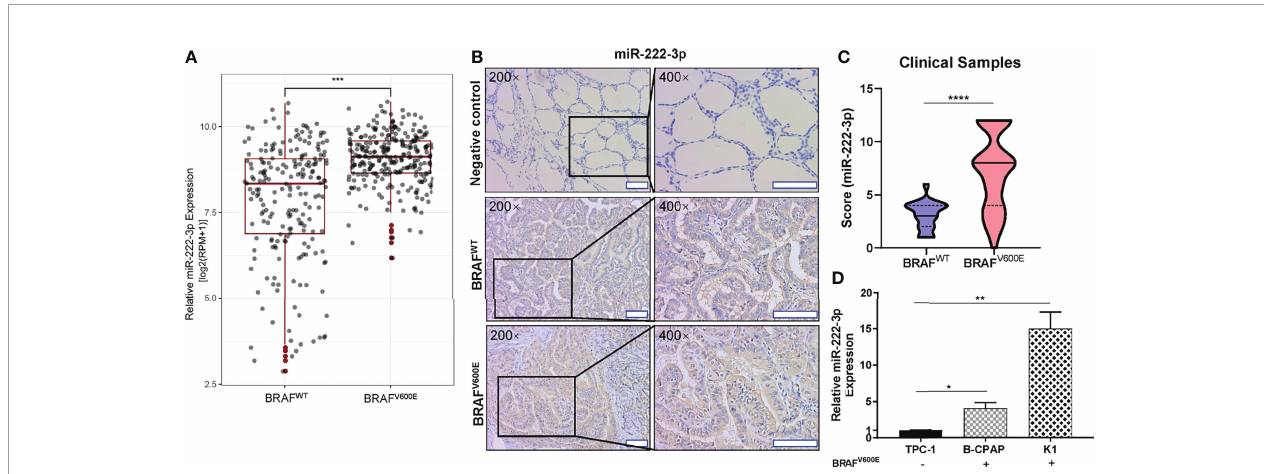
FIGURE 1 | Hsa-miR-222-3p is overexpressed in PTC cells and patients harboring BRAF V600E mutation. (A) Differential analysis of miR-222-3p expression for 491 thyroid cancerous tissues with BRAF WT and BRAF V600E mutation. RPM: reads per million mapped reads. ***p < 0.001. (B) Representative images (200×, 400×) of CISH staining of PTC lesions from clinical patients harboring BRAF WT and BRAF V600E mutation. Negative control from normal thyroid tissues. Scale bar, 100 m M. (C) Mann-Whitney t -test analysis of miR-222-3p ISH score in PTC lesions between BRAF WT and BRAF V600E . The solid line and dotted line respectively represent median and interquartile range, ****p < 0.0001. (D) q-PCR validation of miR-222-3p expression in PTC cell lines including TPC-1, B-CPAP, and K1. Bars represent means ± SD of 3 independent experiments each measured in triplicate. *p < 0.05; **p <